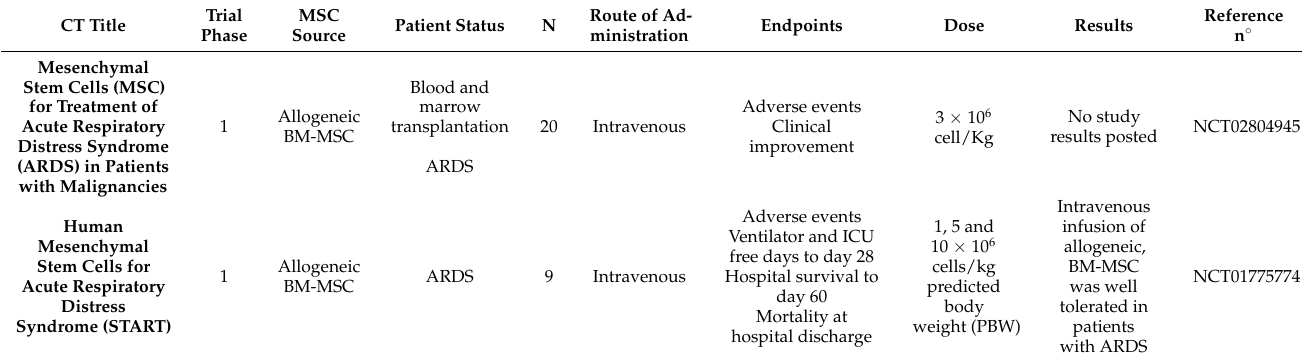
Table 1. Completed clinical trials assessing the safety and efficacy of MSC therapy in